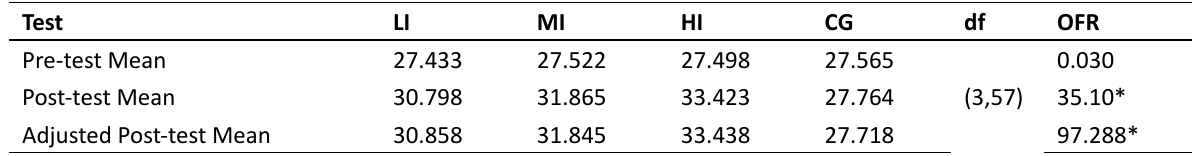
Table 6. Showing the analysis of covariance of pre-test, post-test, and Adjusted post-test on muscular endurance of experimental and control